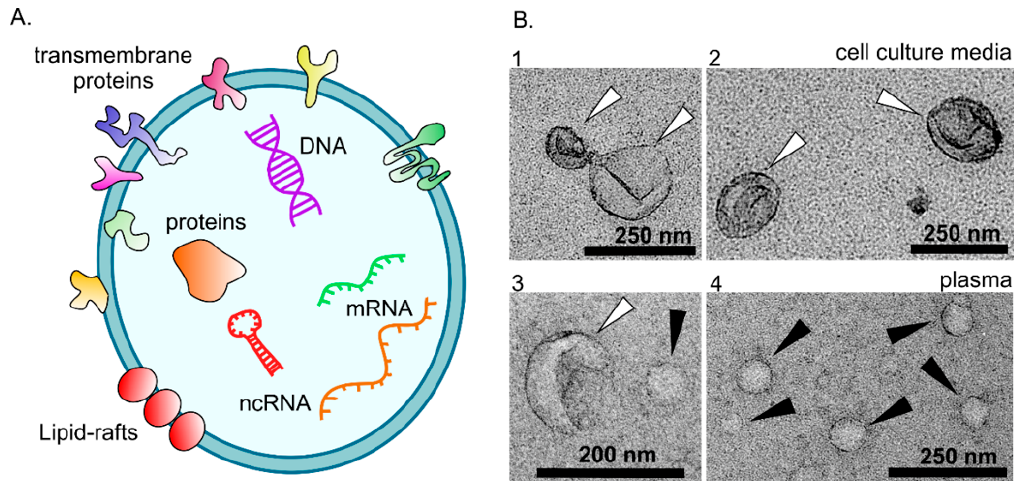
Figure 1. ( A ) A schematic presentation of the structure of extracellular vesicles (EVs). A lipid bilayer encapsulates the water-soluble cargo. EVs can carry a variety of regulatory molecules, including DNAs, messenger RNAs (mRNA), noncoding RNAs (ncRNA), proteins, and enzymes. ( B ) Transmission electron microscope images of EVs (white arrowheads) isolated from mesenchymal stem cell culture media ( B 1 and B 2 ) and rat plasma ( B 3 and B 4 ). The cup-shaped form is caused by the collapse of the water-containing vesicle during the sample preparation. Plasma lipoproteins (black arrowheads in B 3 and B 4 ) show round morphology.